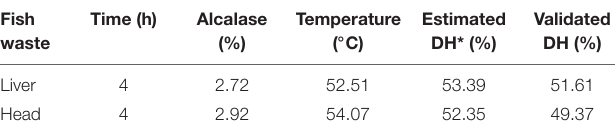
TABLE 2 | Optimization of fish waste